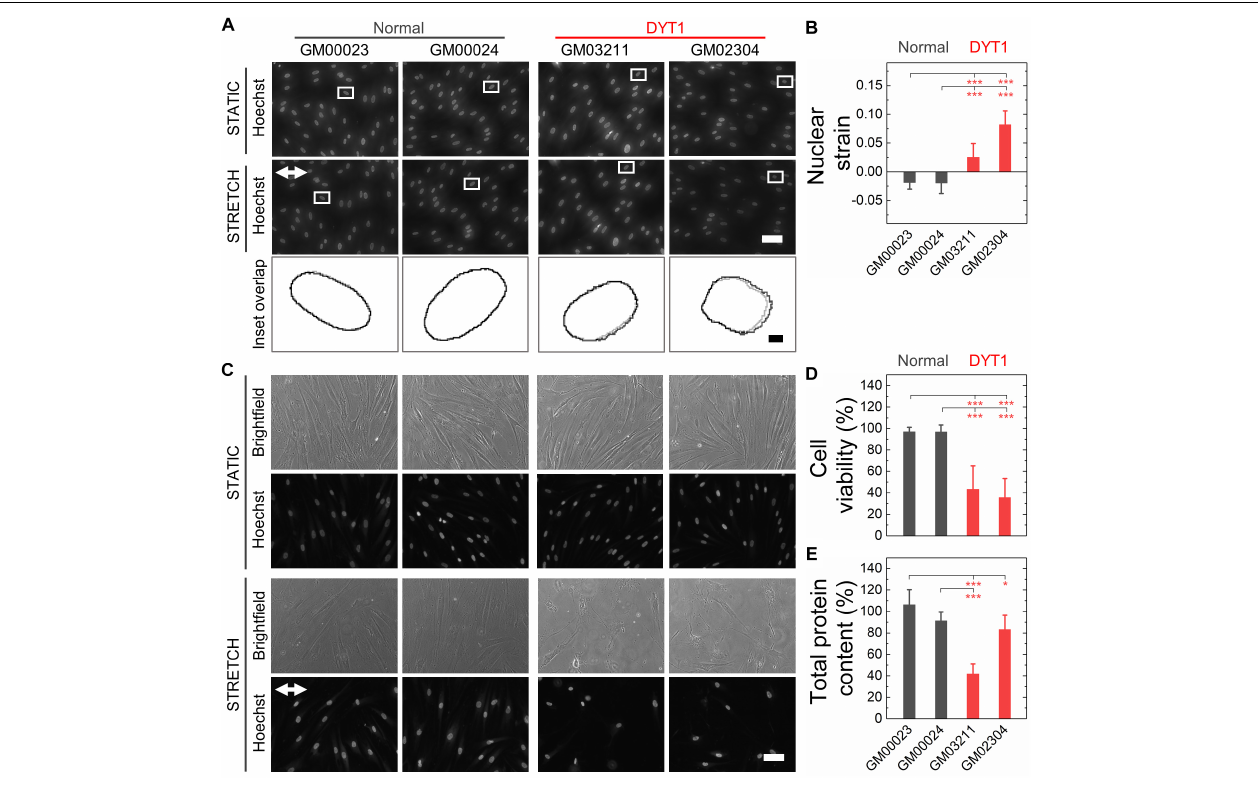
FIGURE 5 | DYT1 dystonia patient-derived fibroblasts exhibit increased nuclear strain and are more susceptible to damage than controls upon mechanical stretch. (A) Representative images of normal and DYT1 dystonia patient-derived fibroblasts stained with Hoechst 33342. Nuclear morphology was examined after cells were exposed to mechanical stretch (5% strain) for 5 min. Images show cells under stretched (Stretch) or non-stretched (Static) conditions. White arrows denotes the direction of uniaxial stretch. Scale, 20 µ m. The magnified inset shows overlapping outlines of nuclei from static (gray) and stretched (black) cells. Inset: scale, 1 µ m. (B) Quantification of nuclear strain (change in nuclear area) due to cell stretching N > 15 cells. Statistical significance was determined using the Welch’s t -test. (C) Representative images of normal and DYT1 dystonia patient-derived fibroblasts after exposure to 24 h cyclical stretch (5% strain) and static conditions. Cells were stained with Hoechst 33342 to visualize nuclei by epifluorescence microscopy. Scale, 20 µ m. (D) Cell viability of normal and DYT1 dystonia patient-derived fibroblasts after exposure to stretch for 24 h and static conditions. The viability data for stretched cells is normalized to static conditions for each cell line. N > 500 cells. (E) Quantification of the total protein content measured from biochemical lysates from cells that were adhered to the PDMS membranes after being exposed to cyclic stretch for 24 h. Total protein content of stretched cells was normalized to the total protein content of cells under static conditions for each cell line. Each